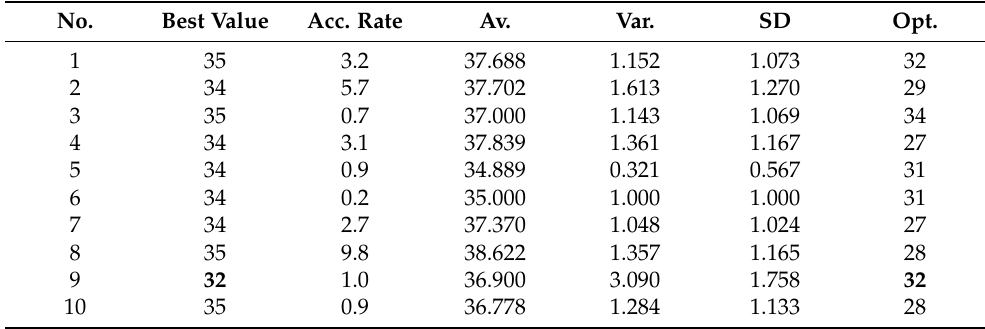
Table 4. Comparison of the experimental results obtained using QBsolv and the optimal solution. No. Best Value Acc. Rate Av.